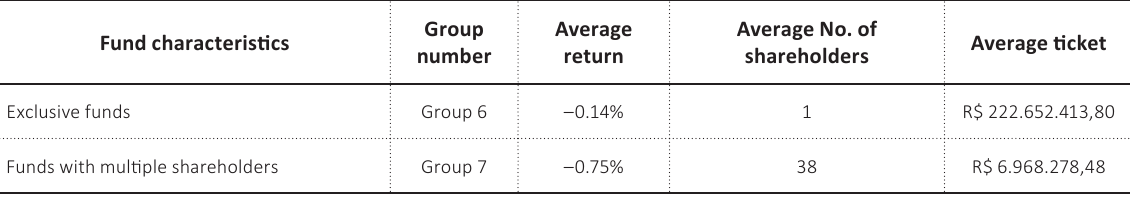
Table 6. Performance of exclusive and non-exclusive FIP funds Fund characteristics